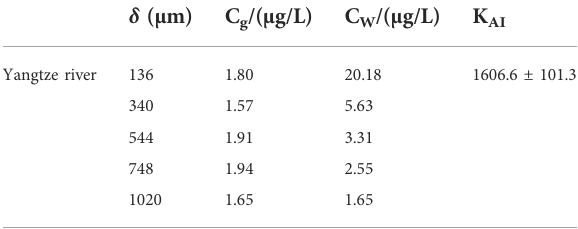
TABLE 2 Interface air-water partition constants of CN for river water.